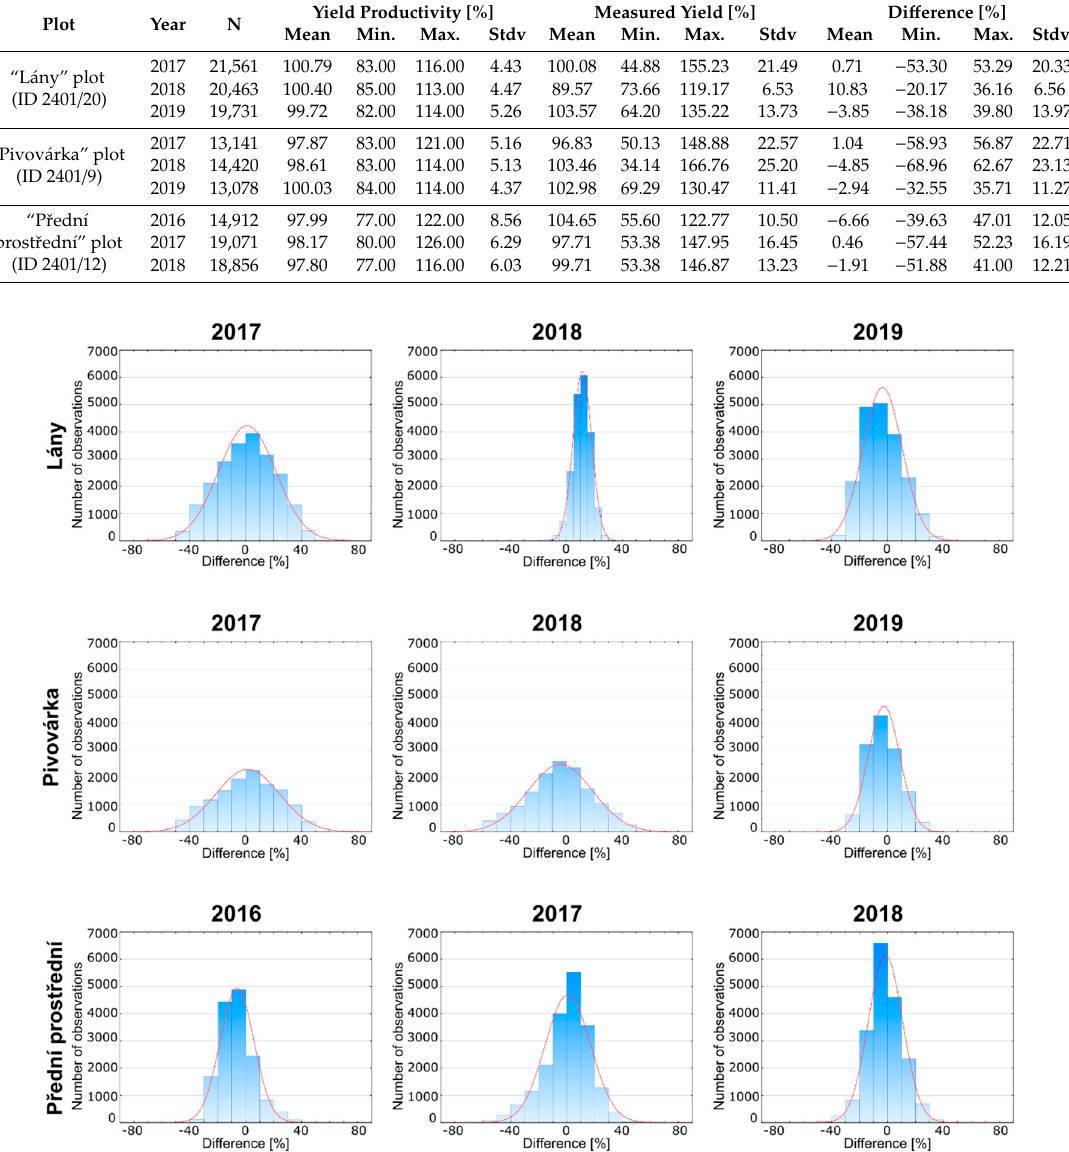
Table 3. Statistical characteristics for the reference points used for the comparison of di ff erences between the yield productivity zones and the measured yield. Note that the “N” column depicts the number of reference points that were used for interpolation and intersected by the concave hulls; this means the number of reference points in Table 3 di ff ers from the number of measured points in Table 2.